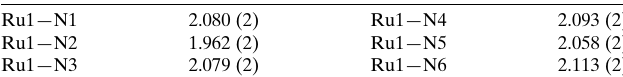
Table 1 Selected bond lengths (A˚ ).